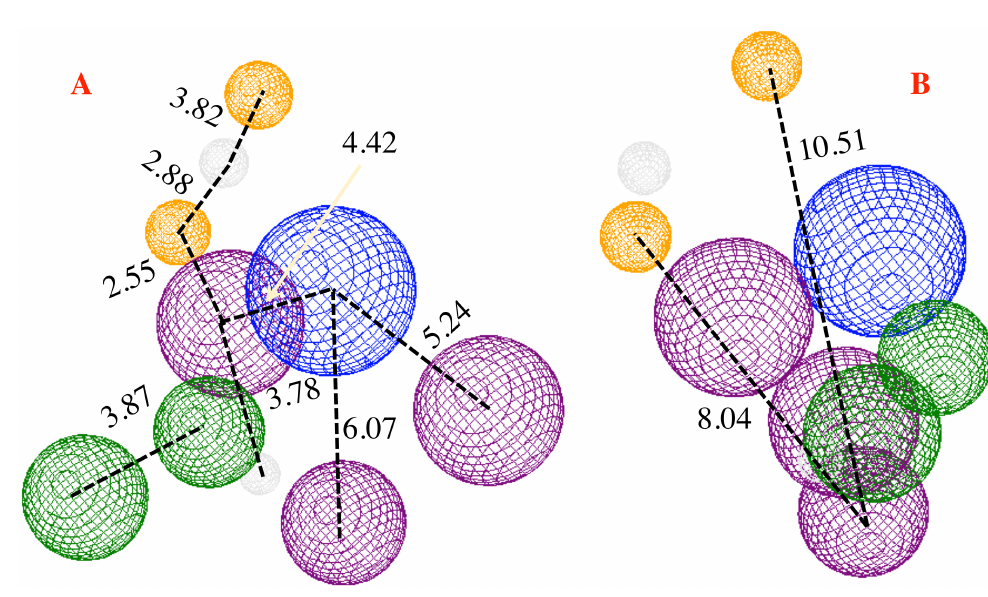
Figure 6 Pharmacophore model for the CoV-2-M Pro protein. (A) Front and (B) lateral view for the pharmacophore model for the Cov-2-M Pro protein. Green spheres depict the hydrophobic segments (Hy), blue spheres are the aromatic segments (Ar), purple spheres represent the hydrophobic and aro- matic segments (Hy – Ar), gray spheres depict the hydrogen donor segments (HD) and the orange sphere represents the hydrogen acceptor segments